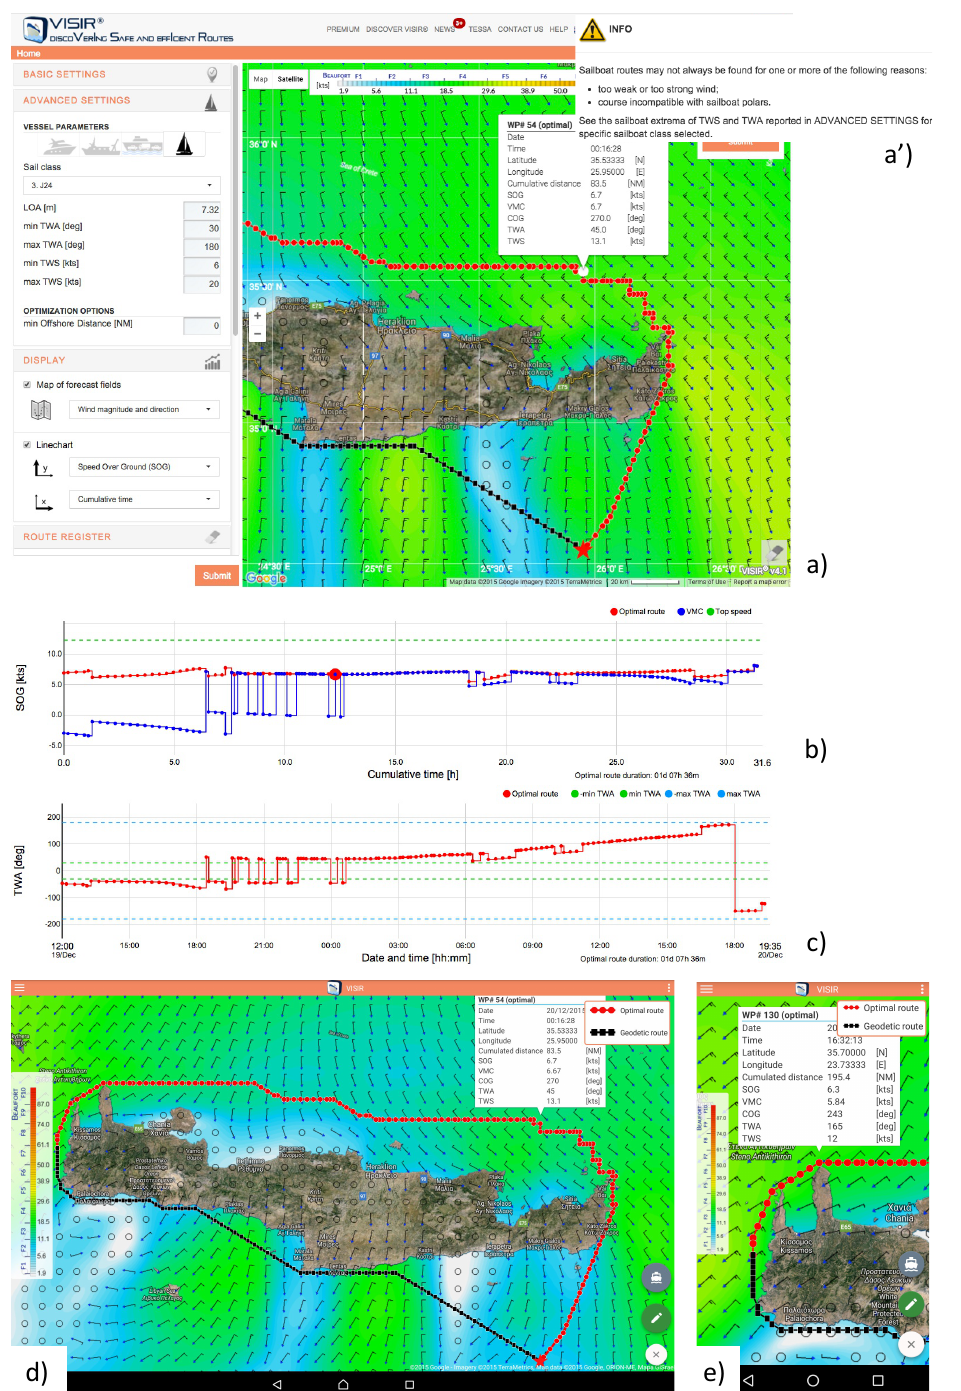
Figure 8. A sailboat route computed by VISIR. The shaded field in the maps is the 10m height wind intensity and its direction. A “First 36.7” sailboat is employed for the computations. Panels (a) , (a’) , (b) , (c) are relative to the web application; panels (d) and (e) to the Android mobile app on a tablet and a smartphone respectively. Panels (b) and (c) are two possible visualizations of the line chart below the map of the web application: in (b) the SOG vs. cumulative time since departure and in (c) the TWA vs. date and time (note the no-go-zone, Sect. 2.3, between the green dashed lines) is visualized. See Sect. 7 for the availability of input and output data relative to this